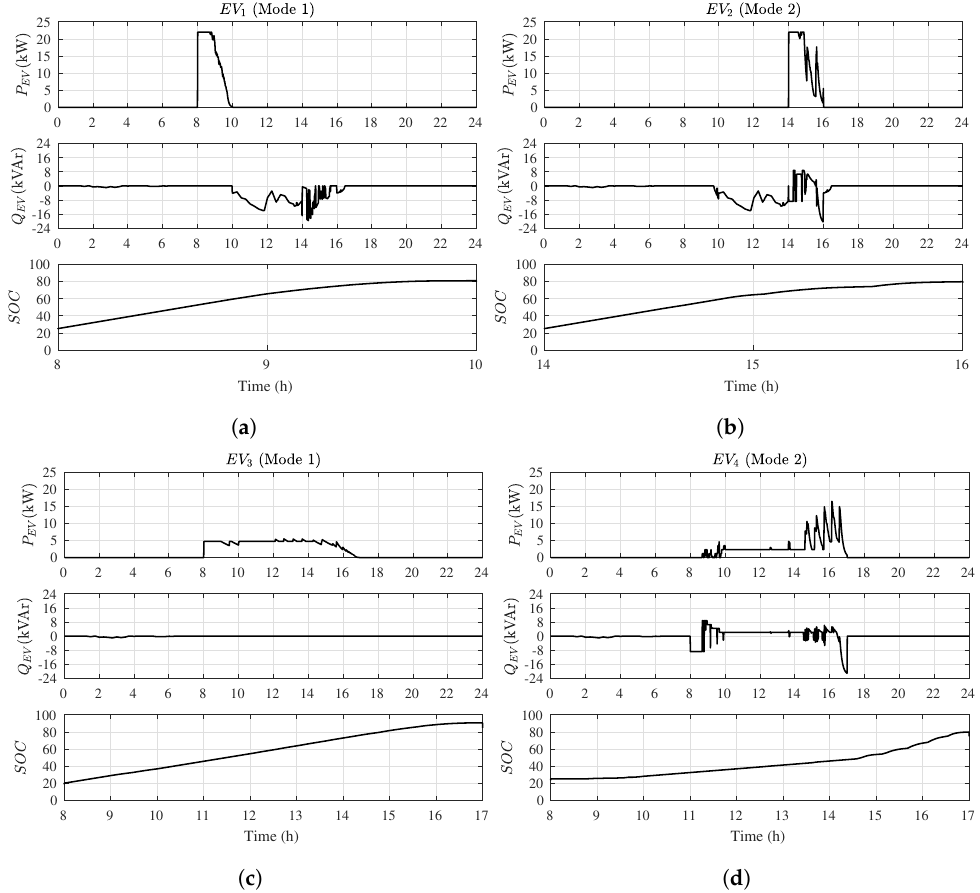
( c ) Figure 15. Active and reactive reference profiles and SOC of each vehicle in the scenario 3: ( a ) EV 1 , ( b ) EV 2 , ( c ) EV 3 and ( d ) EV 4